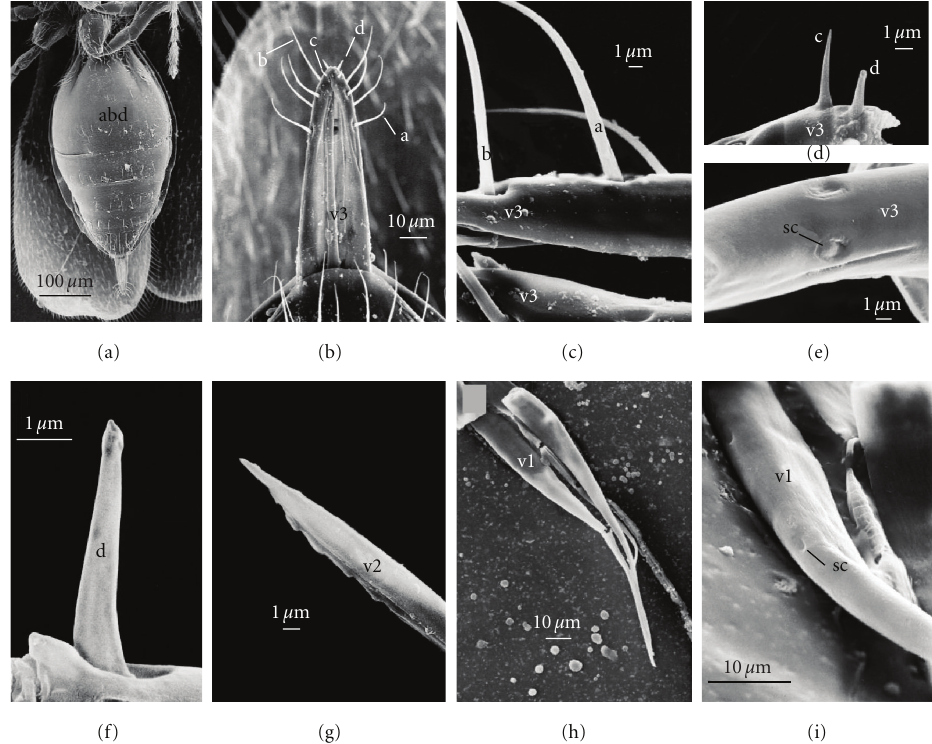
Figure 1: Ovipositor of P. diplosisae . (a) View of the abdomen showing the ovipositor at its distal end. abd: abdomen. (b) Front view of the ovipositor of P. diplosisae . Several sensillae are seen on the 3rd valvulae. a: trichoid sensillum of type a; b: trichoid sensillum of type b; c: sensillum of type c; d: sensillum of type d. (c) Valves 3 showing 2 types of trichoid sensillae. a: sensillum of type a; b: sensillum of type b. (d) Distal end of the 3rd valvulae with 2 types of trichoid sensillae. c: sensillae of type c; d: sensillae of type d. (e) Two campaniform sensillae located at the proximal portion of the 3rd valvulae. v3: 3rd valvula; sc: campaniform sensillum. (f) Sensillum of type d observed on the distal end of the 3rd valvula. d: sensillum of type d. (g) Distal end of the ventral part of a 2nd valvula viewed in profile. Five denticles are seen on this valvula. v2: 2nd valvula. (h) 1st valvula of the ovipositor. They appear large in their proximal portion and more and more slender near their distal end. v1: 1st valvula. (i) Two campaniform sensillae on the proximal portion of a 1st valvula. v1: 1st valvula.